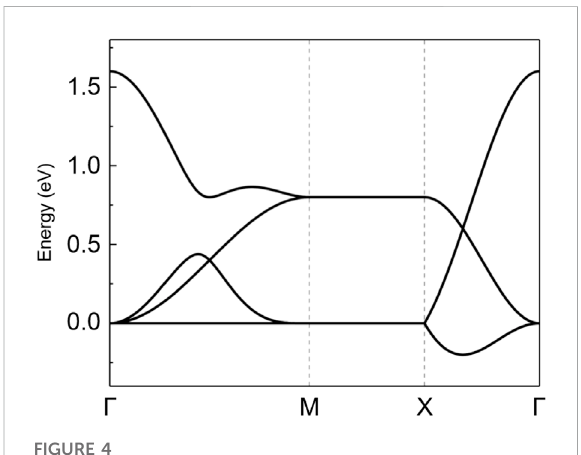
FIGURE 4 Band structure of the spinless lattice model with SG